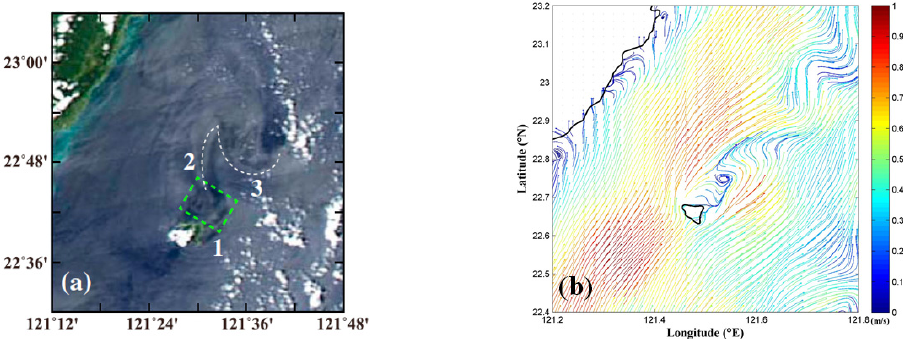
Figure 6. Vortex shedding characteristics from the ( a ) MODIS satellite image and ( b ) the present